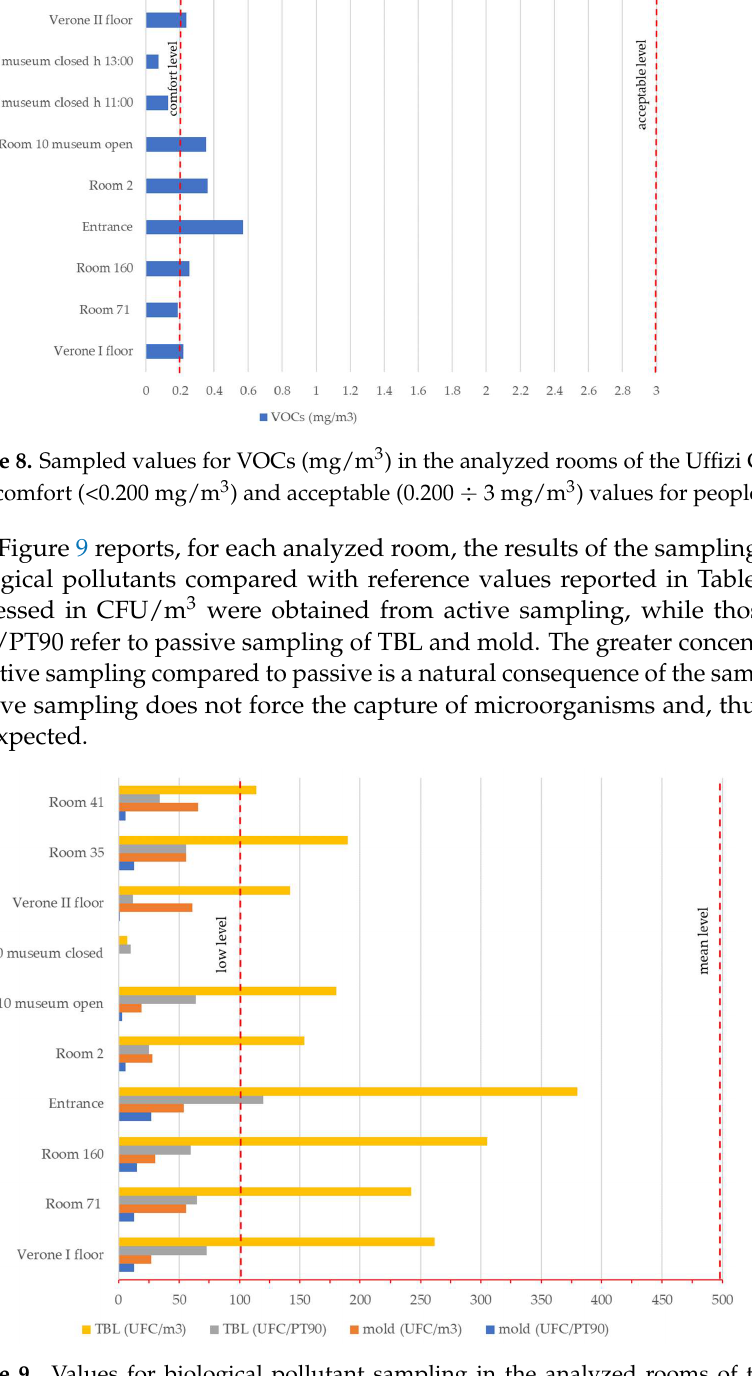
Figure 9. Values for biological pollutant sampling in the analyzed rooms of the Uffizi Gallery com- pared with reference values for TBL and